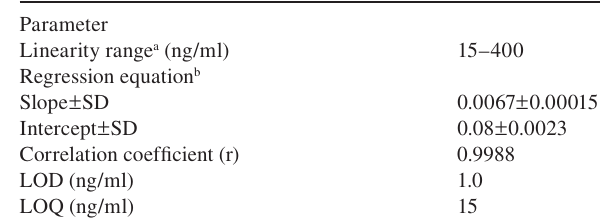
Plasma concentration time profi le of desipramine as the active metabolite of imipramine in a healthy volunteer after a single oral administration of 75 mg of